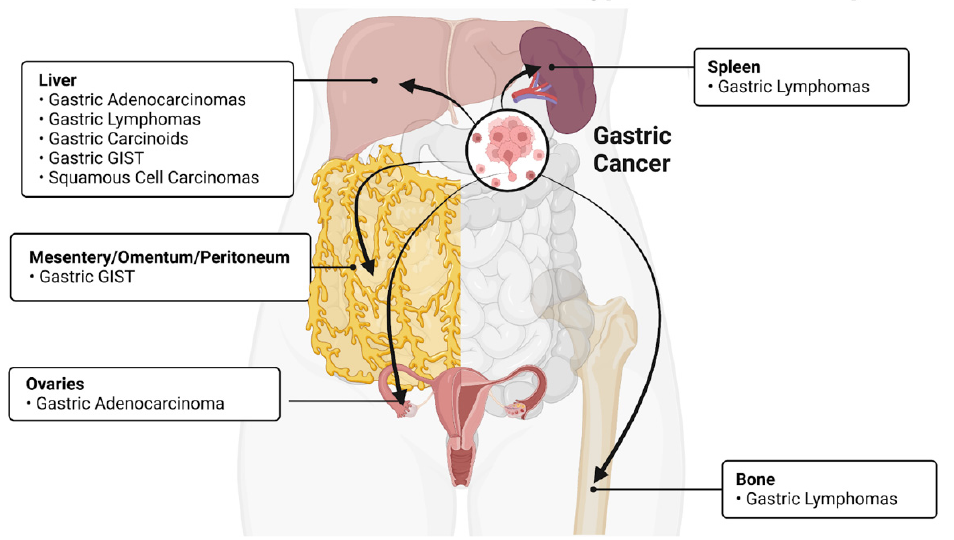
Figure 1. The most common metastasis sites for gastric cancer include the liver, mesentery/omen- tum, spleen, and bone. Figure created using